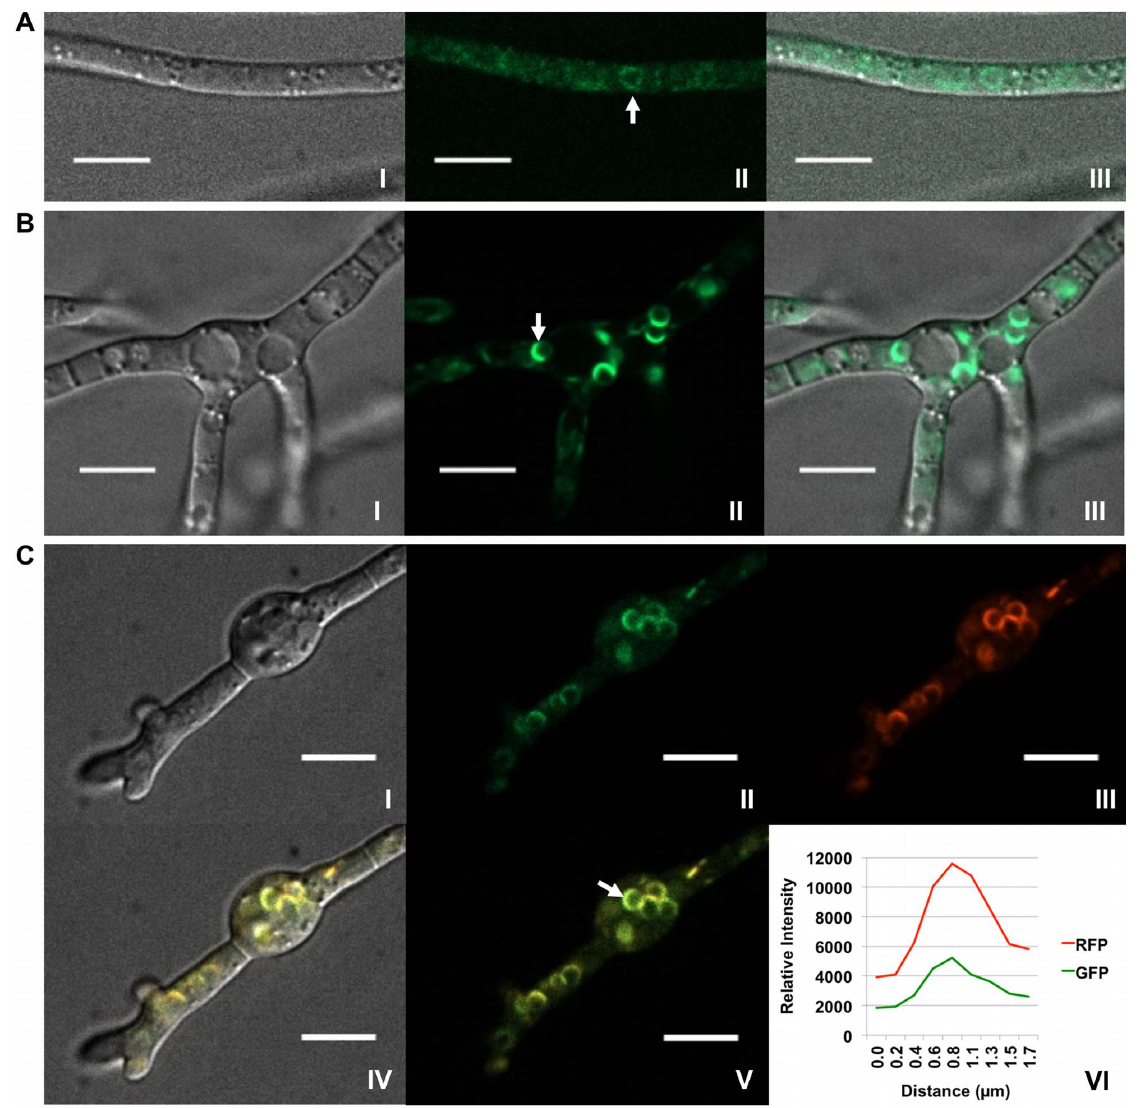
Figure 5. Re-patterning of Hmr1p fluorescence in toxin induced cells. (A) Localization of Hmr1p::GFP in strain PH-1Hmr1::GFP 36 h after suspension in MM where trichothecene biosynthesis does not occur. Confocal bright field DIC (I); GFP (II); and DIC and GFP (III) overlay images are shown. Hmr1p::GFP fluorescence corresponds mostly to diffuse membranous structures within the cell but occasionally to spherical bodies (arrow). (B) Localization of Hmr1p::GFP in strain PH-1Hmr1::GFP 36 h after suspension in TBI medium. Confocal bright field DIC (I); GFP (II); DIC and GFP (III) overlay images show a shift in localization of Hmr1p::GFP (arrow) primarily to spherical organelles. (C) Co-localization of Hmr1p::GFP and Tri4p::RFP in strain PH-1Hmr1::GFP/Tri4::RFP 36 h after suspension in TBI medium. Confocal bright field DIC (I); GFP (II); RFP (III); and GFP/RFP/DIC (IV) overlay images are shown. Co-fluorescence of GFP and RFP (V) within the periphery of a spherical organelle (arrow) and signal intensity of GFP and RFP emission spectra (VI) generated from a line bisecting the spherical organelle show spatial overlap of the separate emission fluorescence. Scale bar=10 m m.